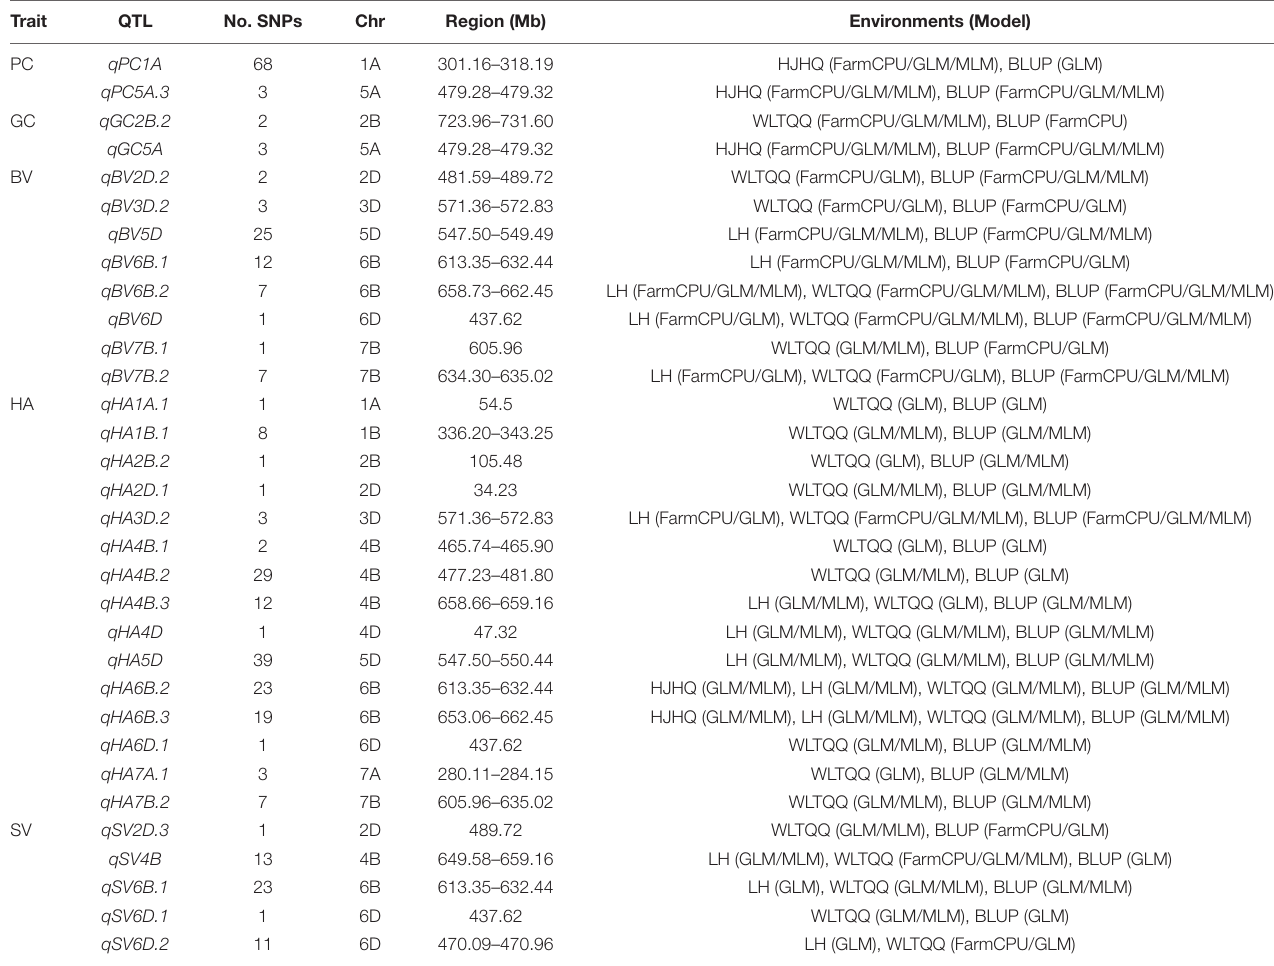
TABLE 3 | Details regarding the 32 stable QTL identified simultaneously in at least one environment and on the basis of BLUP